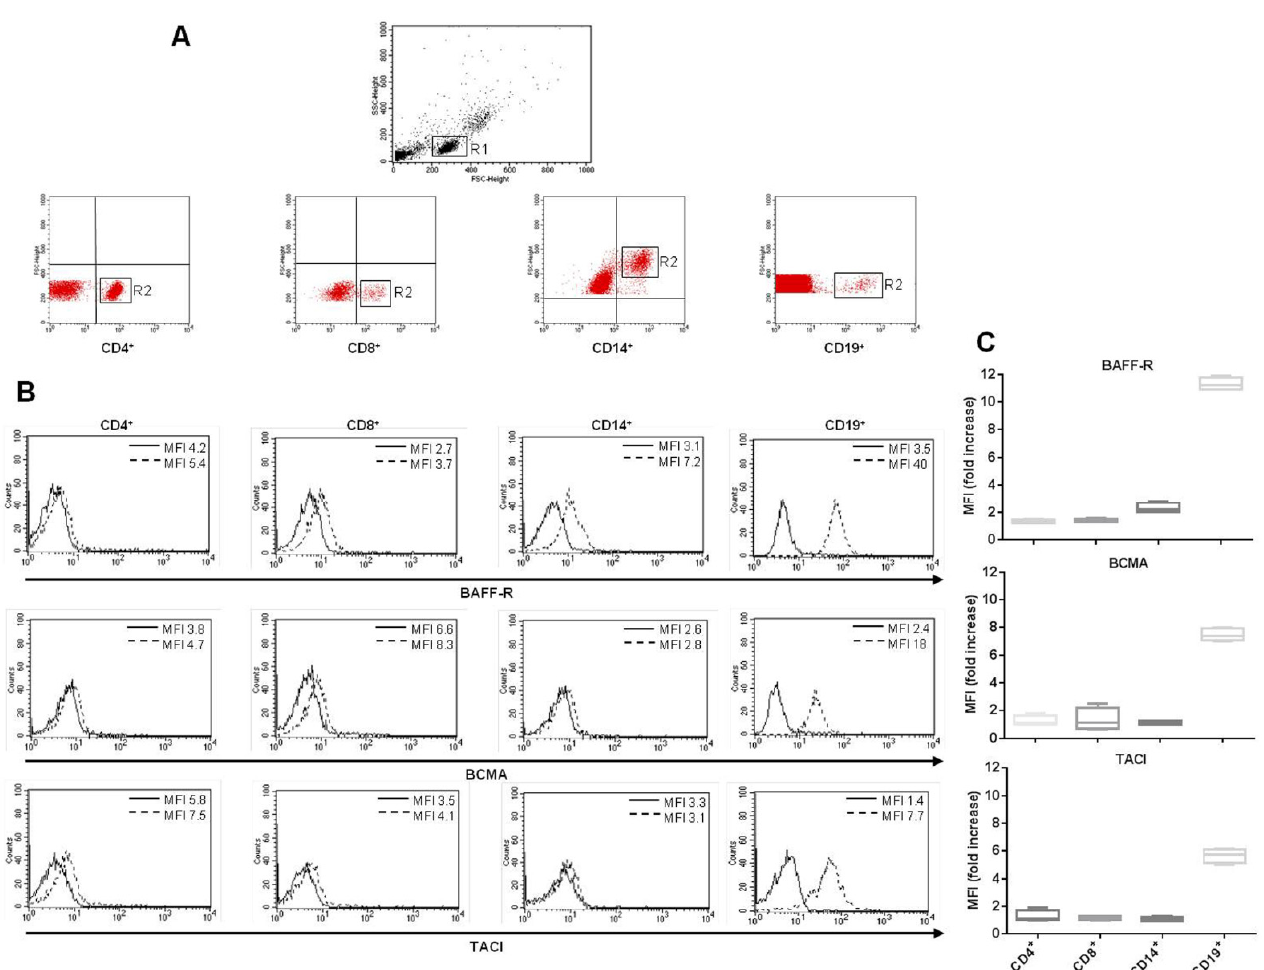
Figure 6. Surface expression of BAFF-R, BCMA, and TACI (BLyS receptors) on CD4 + , CD8 + T cells and CD14 + monocytic cells of SLE patients. ( A ) Phenotypic characterization of PBMCs from 26 SLE patients at baseline (before treatment with belimumab), showing the expression of CD4, CD8, CD14, and CD19. Cytofluorimetric images show PBMC populations (R1 gate, upper panel) and CD4 + , CD8 + , CD14 + , and CD19 + cells (R2 gate, lower panels). Results from a representative experiment are shown. ( B ) Flow cytometric analysis after staining of PBMCs with anti-BAFF-R, anti-BCMA, and anti-TACI mAbs. CD19 + B cells were used as positive controls for the surface expression of the receptors. Isotypic control staining is represented by the solid black line, while anti-BLyS receptors are represented by the broken black line. Results obtained in a representative experiment are shown. ( C ) Box and whisker plots indicate the levels of BLyS receptors observed in CD4 + , CD8 + , and CD14 + cells, expressed as mean fluorescence intensity (MFI). CD19 + cells are displayed as positive controls for the expression of BLyS receptors. Results are represented as the mean ± standard deviation (SD) of the fold increase.